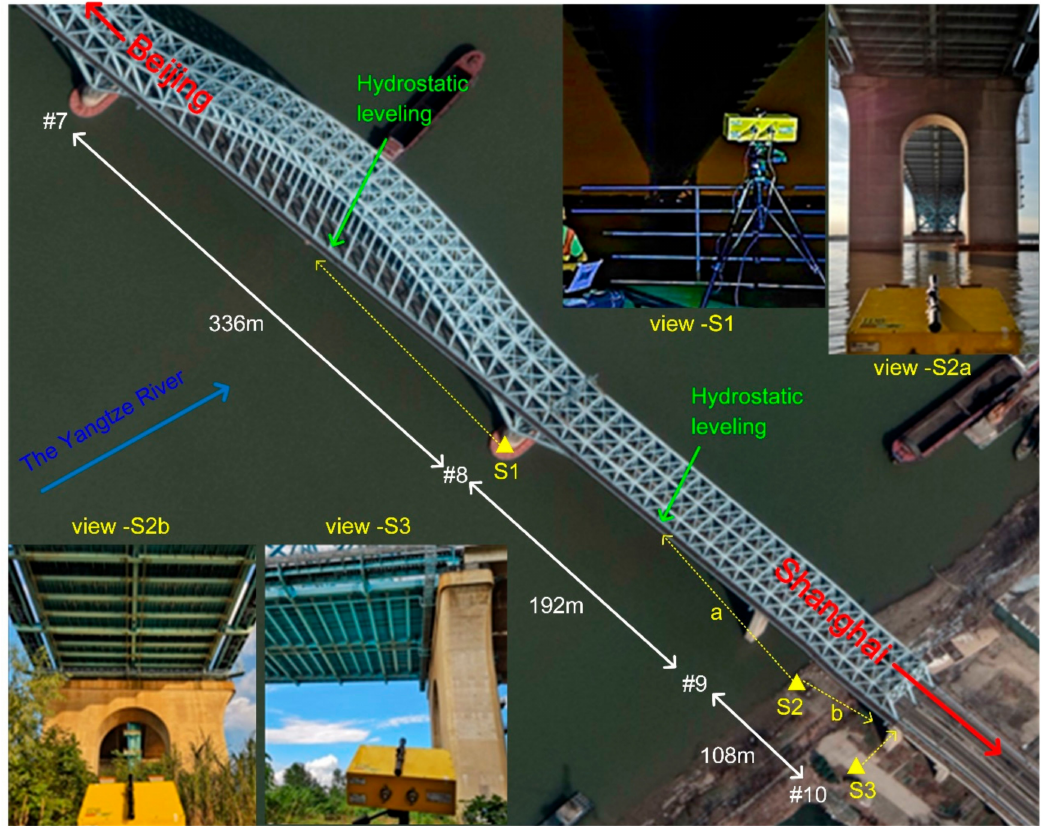
Figure 4. Google Earth image of the NDHRB southern part. The IBIS-S installations (S1, S2, S3) are marked with yellow triangles and the approximated radar LOS is highlighted with yellow dotted lines; the four pictures show the corresponding views (view S1, view S2a, view S2b and view S3); the positions of the hydrostatic leveling are also indicated with green